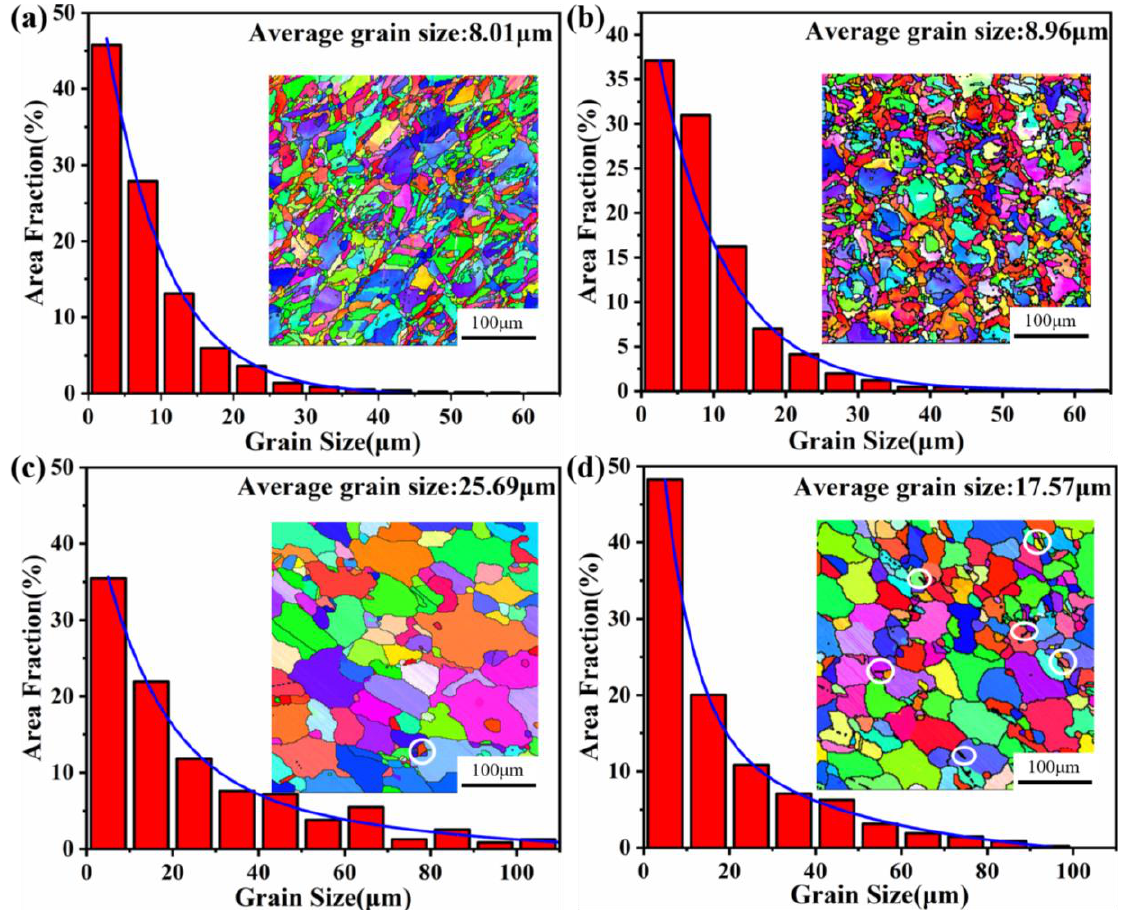
Figure 3. IPF maps obtained from the EBSD analysis in the XZ plane of the alloys and the corresponding grain size distribution diagram: ( a ) as-printed 13Co alloy; ( b ) as-printed 35Co alloy; ( c ) heat-treated 13Co alloy; ( d ) heat-treated 35Co alloy. The white circles represent twins.